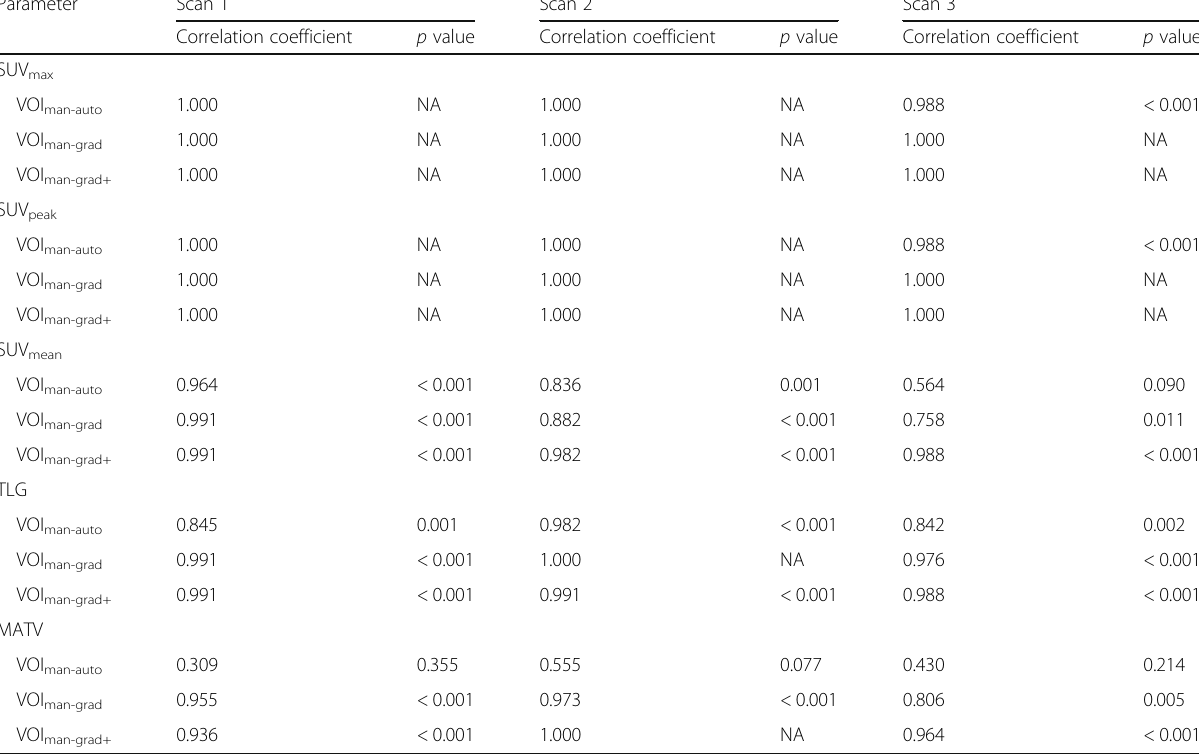
Spearman ’ s test for correlations was used to calculate significance. The strongest correlation for the three PET scans was found between the VOI man and the VOI grad+ , as indicated in gray VOI volume of interest, VOI man manually drawn VOI, VOI auto automatically drawn VOI, VOI grad VOI based on the gradient between voxels, VOI grad+ VOI grad + necrosis, 18 F-FDG PET-CT fluorine-18-fluorodeoxyglucose positron emission tomography with computed tomography, SUV